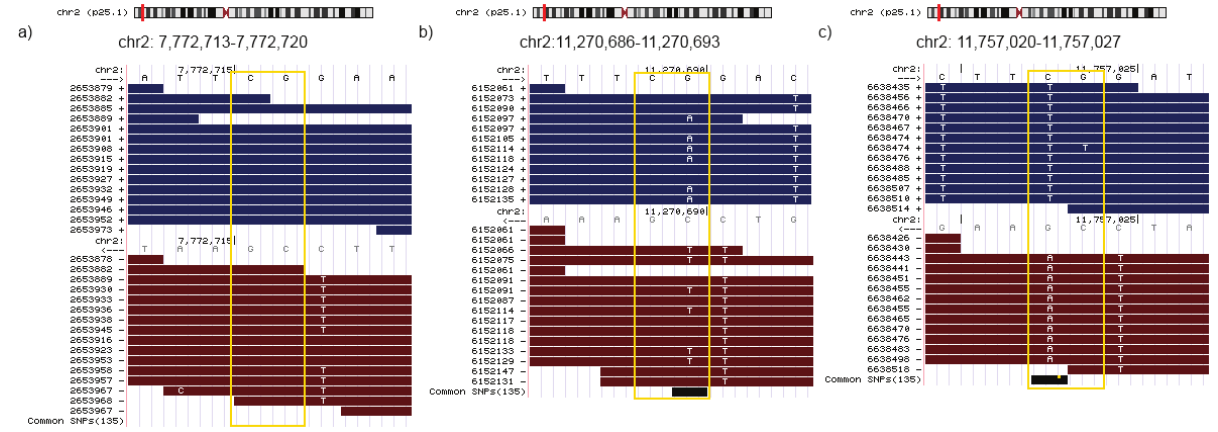
Figure 1. SNV detection in bisulfite converted reads. Sequence variation can be detected for a cytosine position analyzing the nucleotide frequency at the same position but on the complementary strand. Bisulfite conversion does not affect the guanine on the complementary strand, therefore the presence of any other base (H=A,C,T) might indicate the existence of an SNV. The figure illustrates three different situations: ( a ) a methylated cytosine in a CpG context without sequence variation (all reads that map to the position independently of the strand carry a cytosine in the corresponding position), ( b ) a heterozygous SNV (genotype C/T, SNV detected on the ‘+’ strand) and ( c ) a homozygous SNV (genotype T/T, SNV detected on the ‘-’ strand). The example in b ) shows a heterozygous SNV; the 6 reads with A/G mismatch from a total of 11 reads mapping the position indicate a heterozygous variation. Furthermore, we can conclude that the cytosine allele is methylated (7 reads with C/C matches to the ‘-’ strand). The case illustrated in part c ), shows 12 reads that show C/T mismatch (‘+’ strand in blue in the upper part). Without looking at the complementary strand, the inference would be a completely un-methylated cytosine. However, the 11 reads that map to the complementary strand show an A/G mismatch at the corresponding position (we would expect guanines in the case of bisulfite conversion). Note that on bisulfite treated datasets only G/A mapped on the ‘+’ strand and C/T on the ‘-’ strand (refereed to the ‘+’ strand) can be used for SNV calling purposes. The figure was generated using the UCSC Genome Browser 41